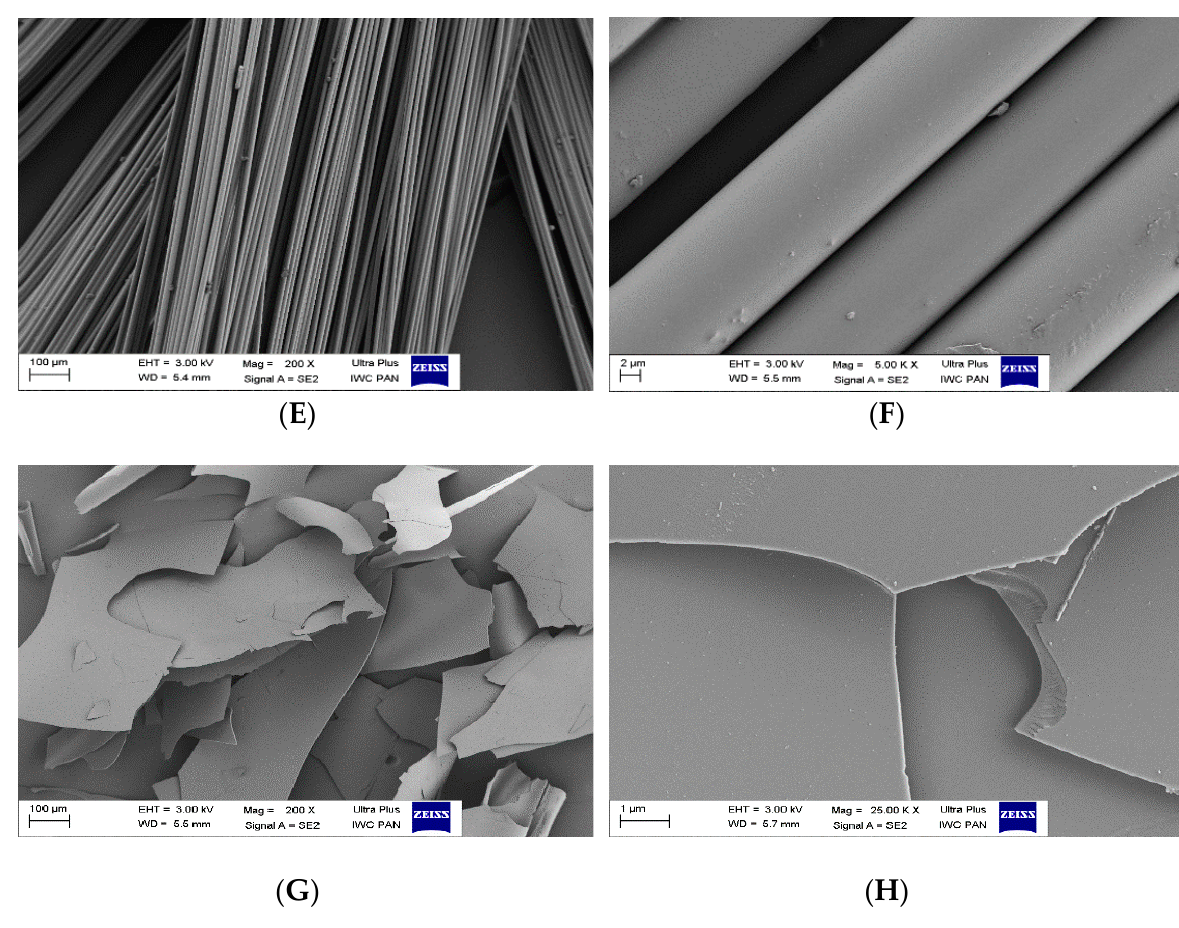
Figure 1. SEM photos: ( A , B )—graphene flakes; ( C , D )—carbon nanotubes; ( E , F )—basalt fibers (BFS); ( G , H )—basalt flakes (BFL).